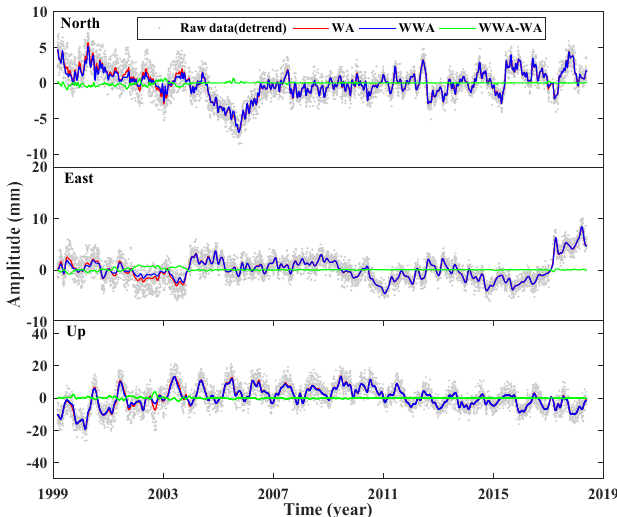
Figure 9. Extracted signals with wavelet analysis (WA) (red line) and WWA (blue line) from BJFS position time series, as well as their difference (green line)